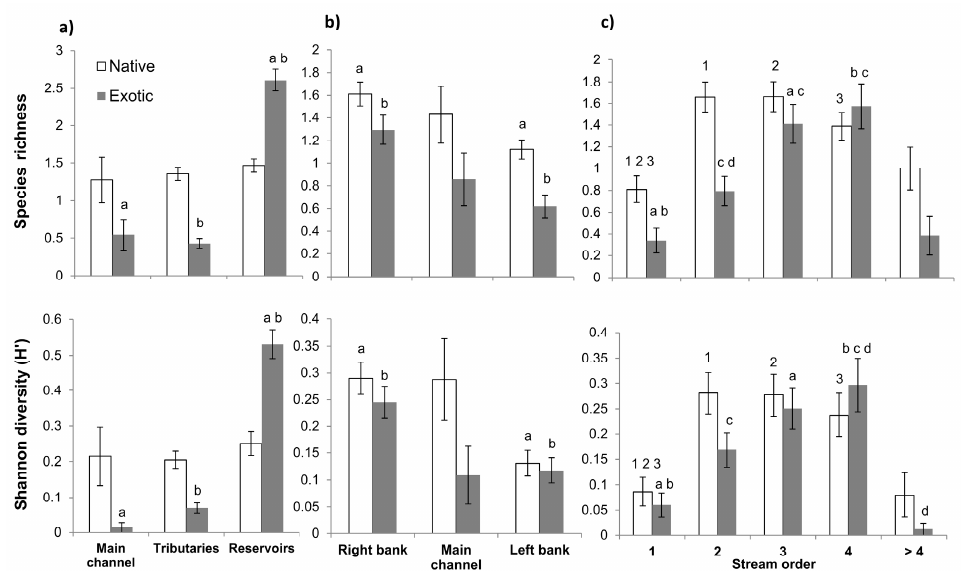
Figure 3. Main fish biodiversity descriptors (average species richness and Shannon H’ diversity index) for native and exotic species at different aquatic habitat typologies in the Guadalquivir Basin. Mainstream, tributaries and reservoirs ( a ); mainstream, left and right bank tributaries ( b ) and stream order ( c ), according to Strahler (1964). Error bars indicate standard error (SE). The same letter above bars shows that values are statistically different (Dunn’s post test; α = 0.05) when Kruskal–Wallis p < 0.05.